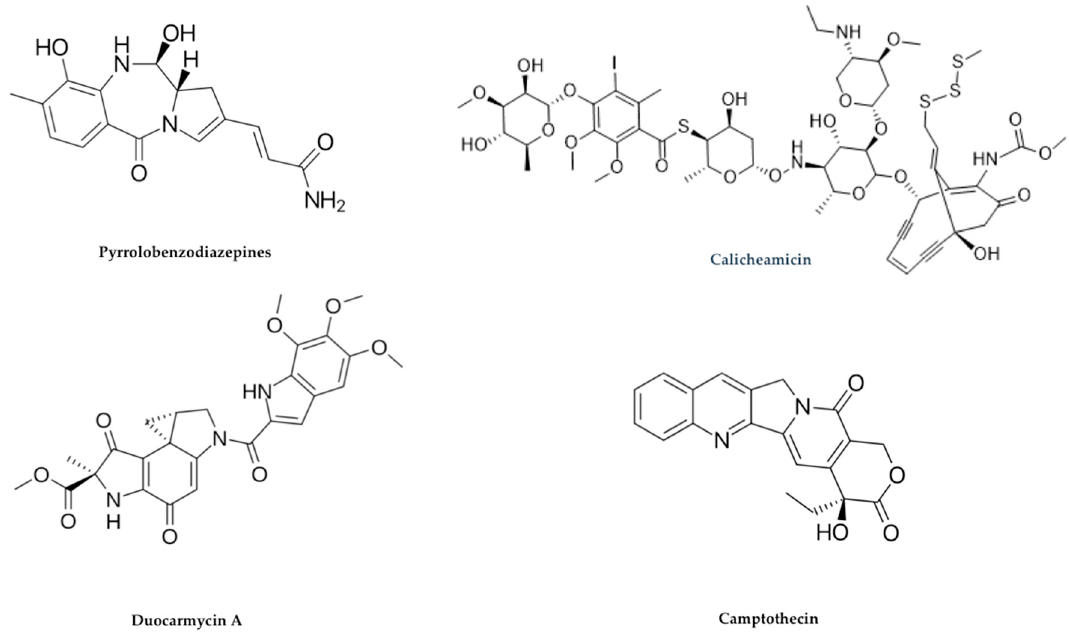
Figure 9. Examples of DNA-damaging drug payloads.